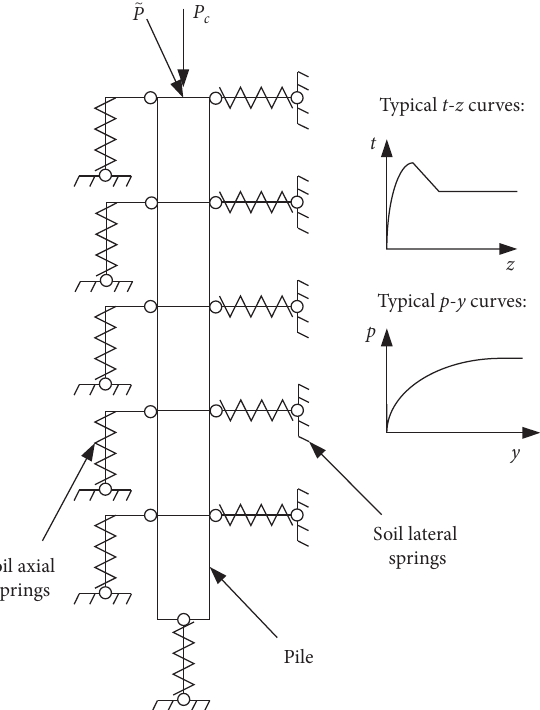
Figure 1: Pile-soil interaction